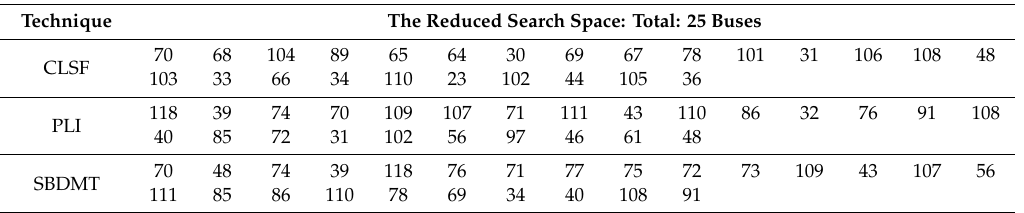
Table 13. The reduced search space by SBDMT comparing to CLSF and PLI for the 118-bus system. Technique